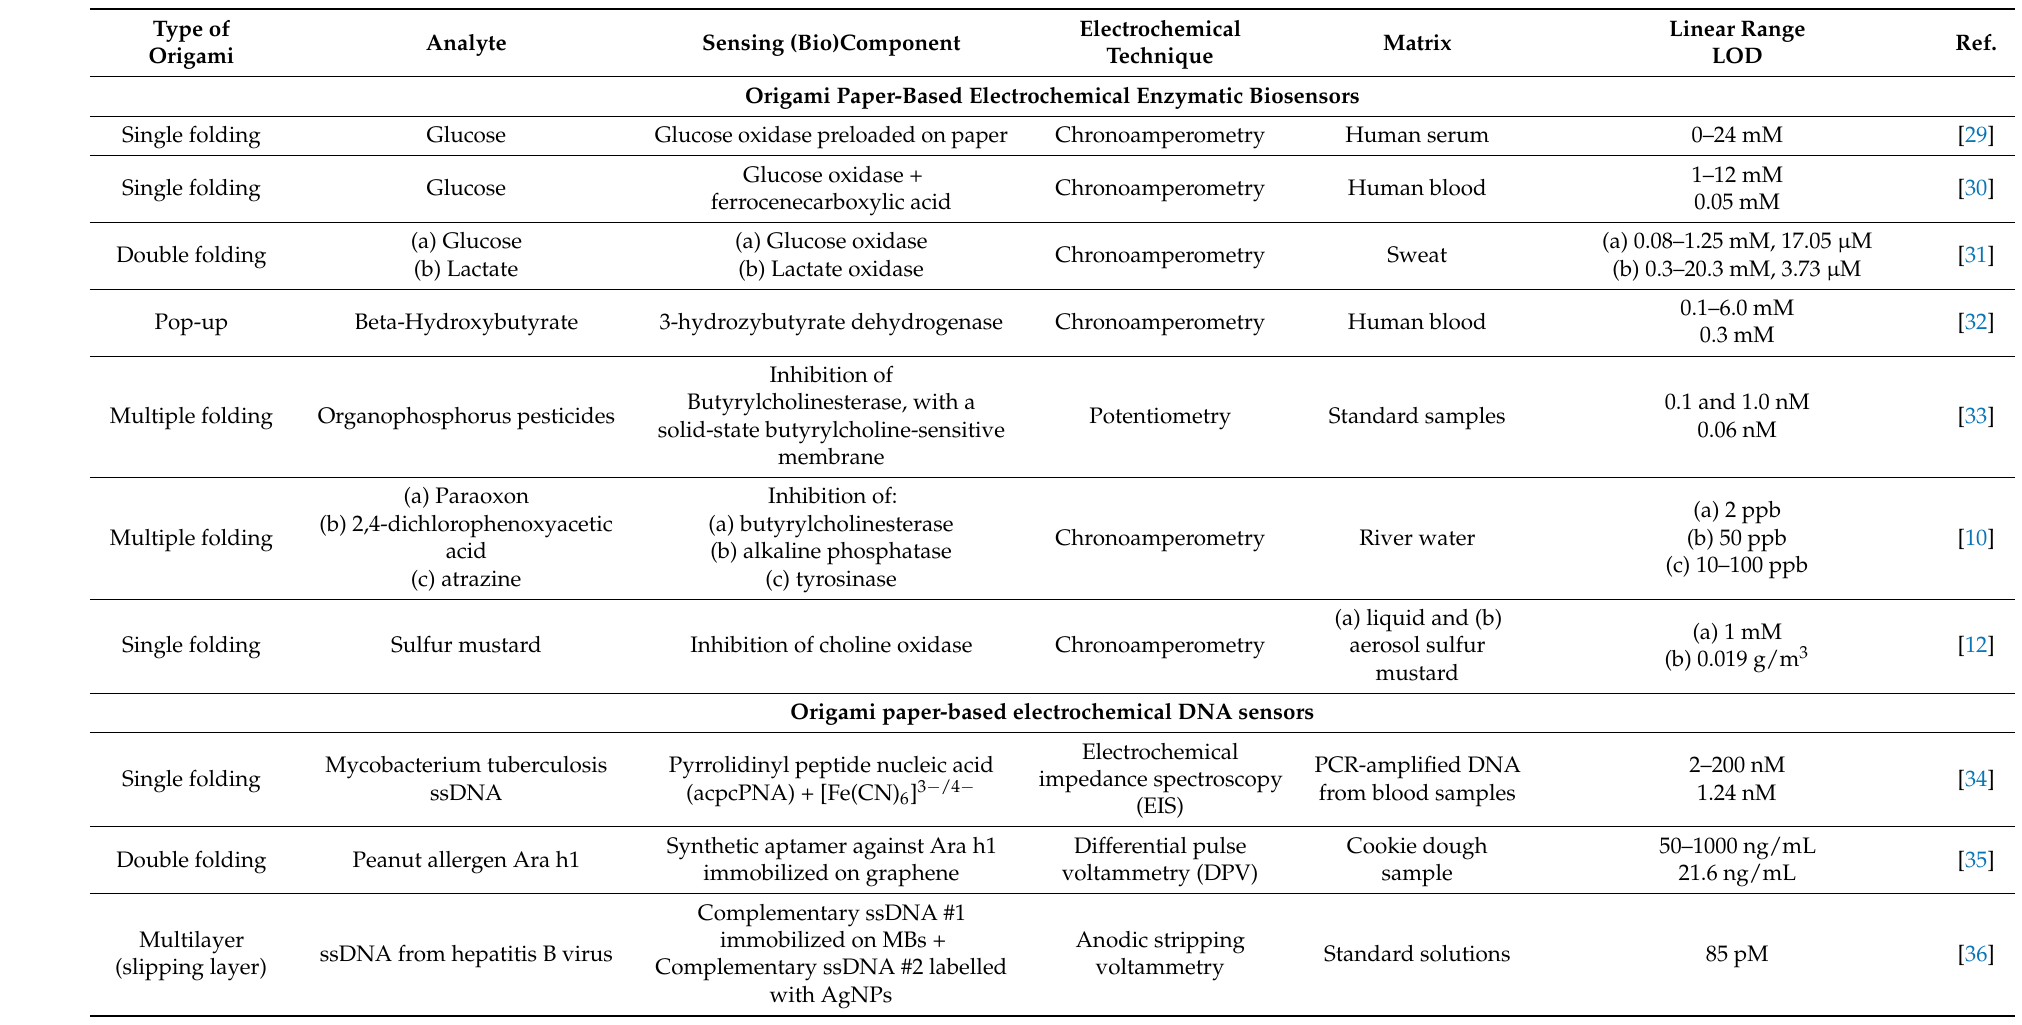
Table 1. Summary of the principal features of the origami paper-based electrochemical